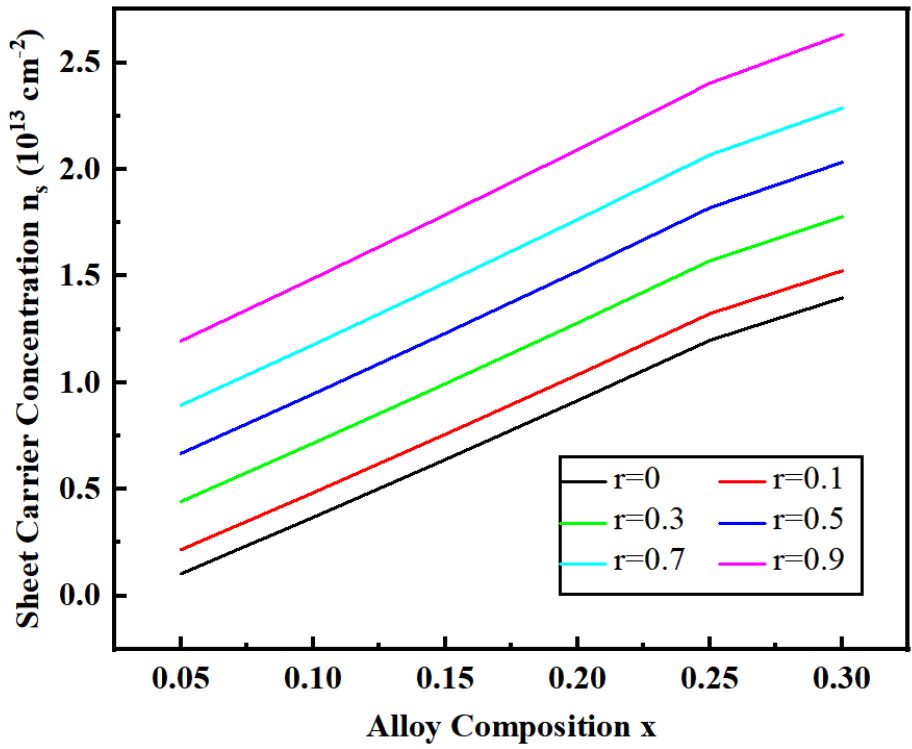
Figure 2. The calculated density n S of 2DEG in AlGaN/InGaN increases with the Al % and r in the In 0.1 Ga 0.9 N